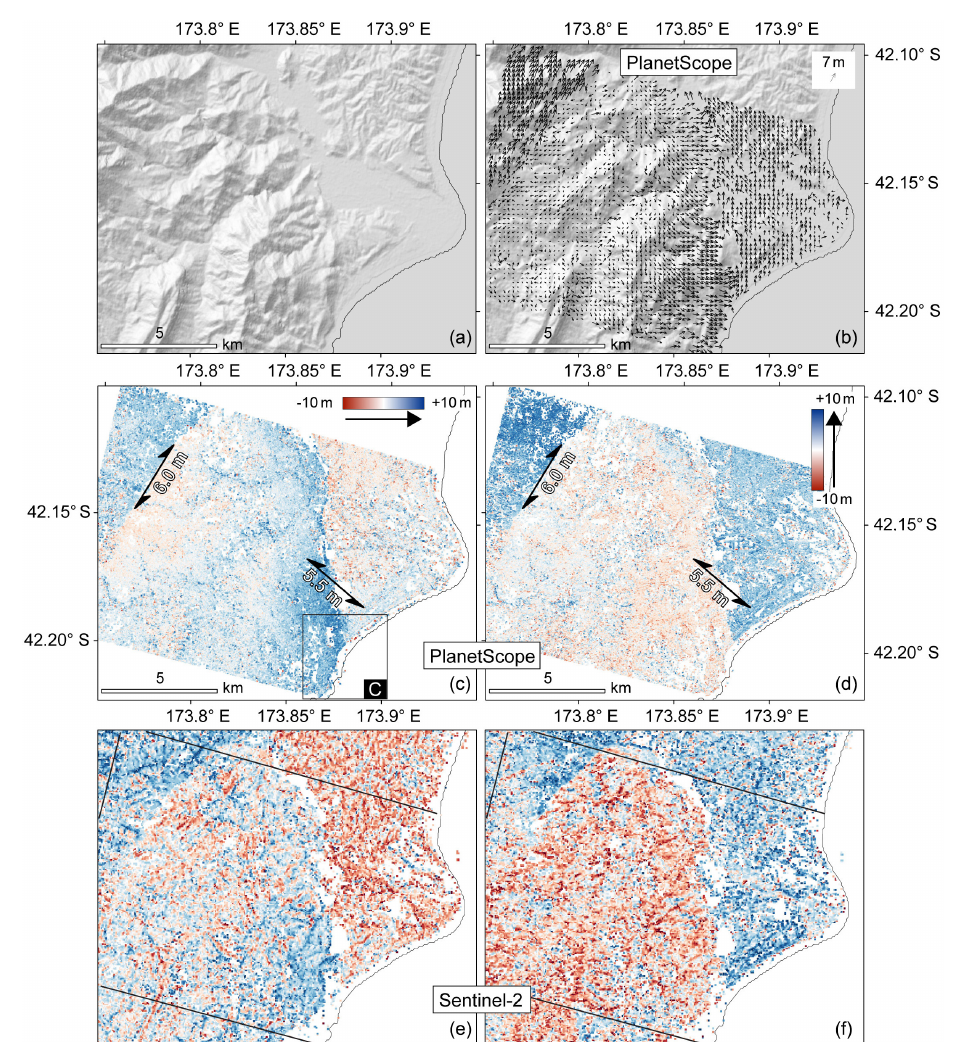
Figure 3. (a) Hillshade of SRTM elevation model. (b, c, d) Horizontal surface displacements from PlanetScope images of 27 October–28 November 2016. (b) Vectors measured originally with 20m grid spacing are resampled to 200m spacing; SRTM hillshade in background. (c) W–E component, (d) S–N component with 20m spacing. Location of figure: A in Fig. 1. The double arrows indicate the approximate direction and the according numbers the approximate magnitude of relative displacement over ruptures. Rectangle C: Fig. 5. Lower row (e, f) is as middle row but displacements from Sentinel-2 data of 3 October and 5 December 2016; same colour